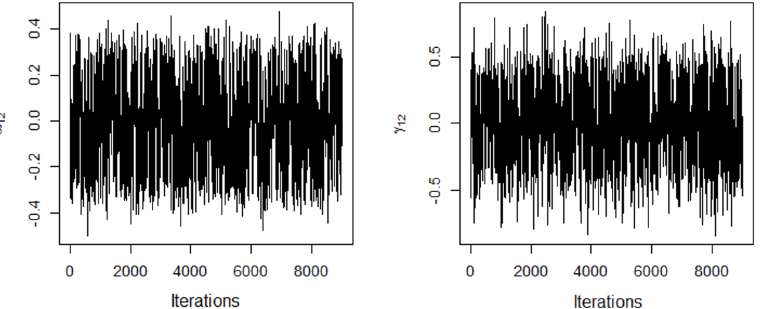
Fig 2. Traces of the chains for the first two coordinates of the genotype and environment singular vectors using the AMMIBS model, without restricting the